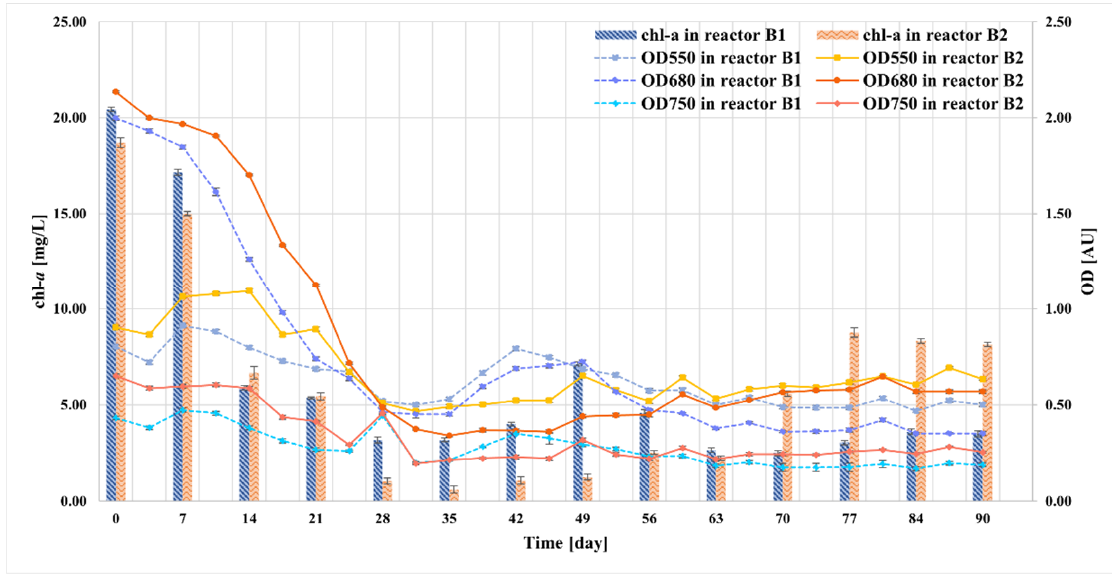
Figure 6. Change in the chlorophyll a concentration and optical density at 550, 680, and 750 nm during the treatment of the liquid digestate.